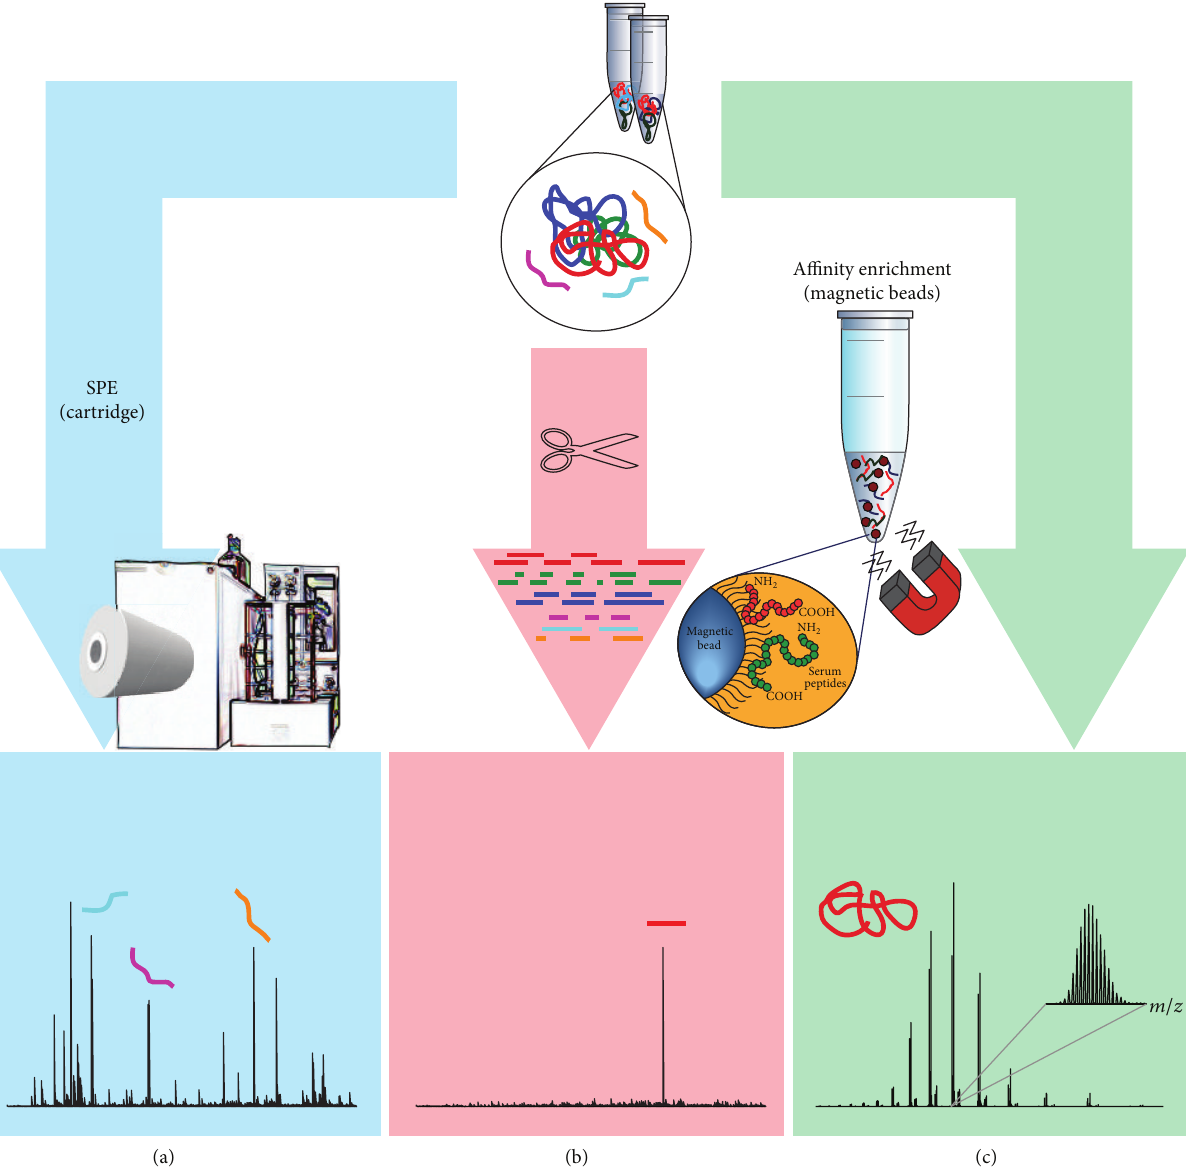
Figure 2: Starting with a complex body fluid sample a specific peptide or protein can be enriched by means of immunoaffinity capture. Whereas a subfraction of the sample is analyzed in an SPE approach, profiling compounds that match the binding capabilities of the sorbent (a), affinity enrichment results in “clean” mass spectra (proteolytic peptide in (b), intact protein in